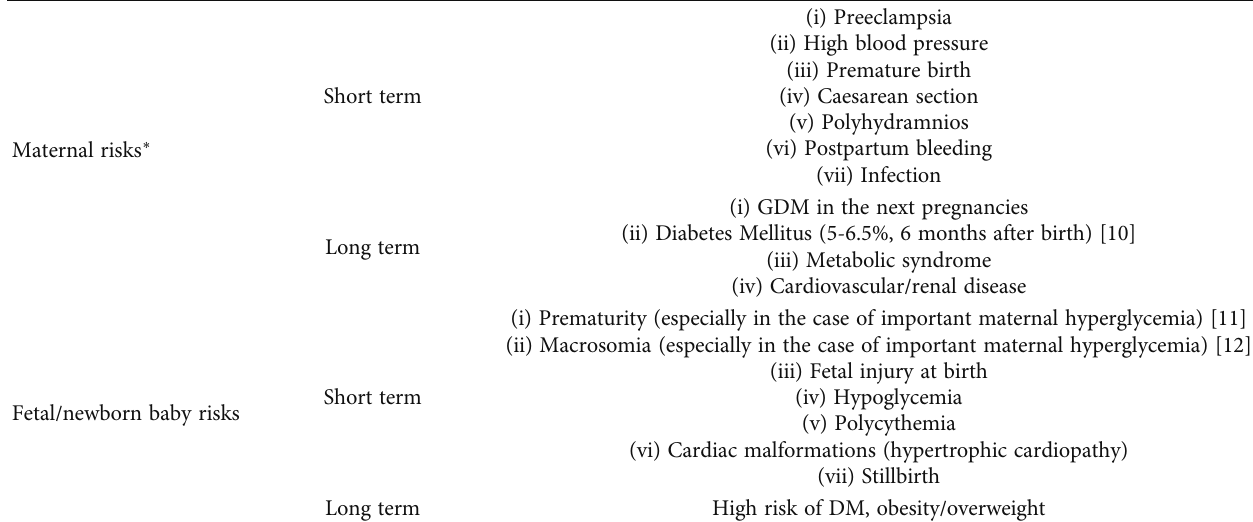
Table 2: E ff ects of maternal hyperglycemia on the mother and o ff spring — adapted after